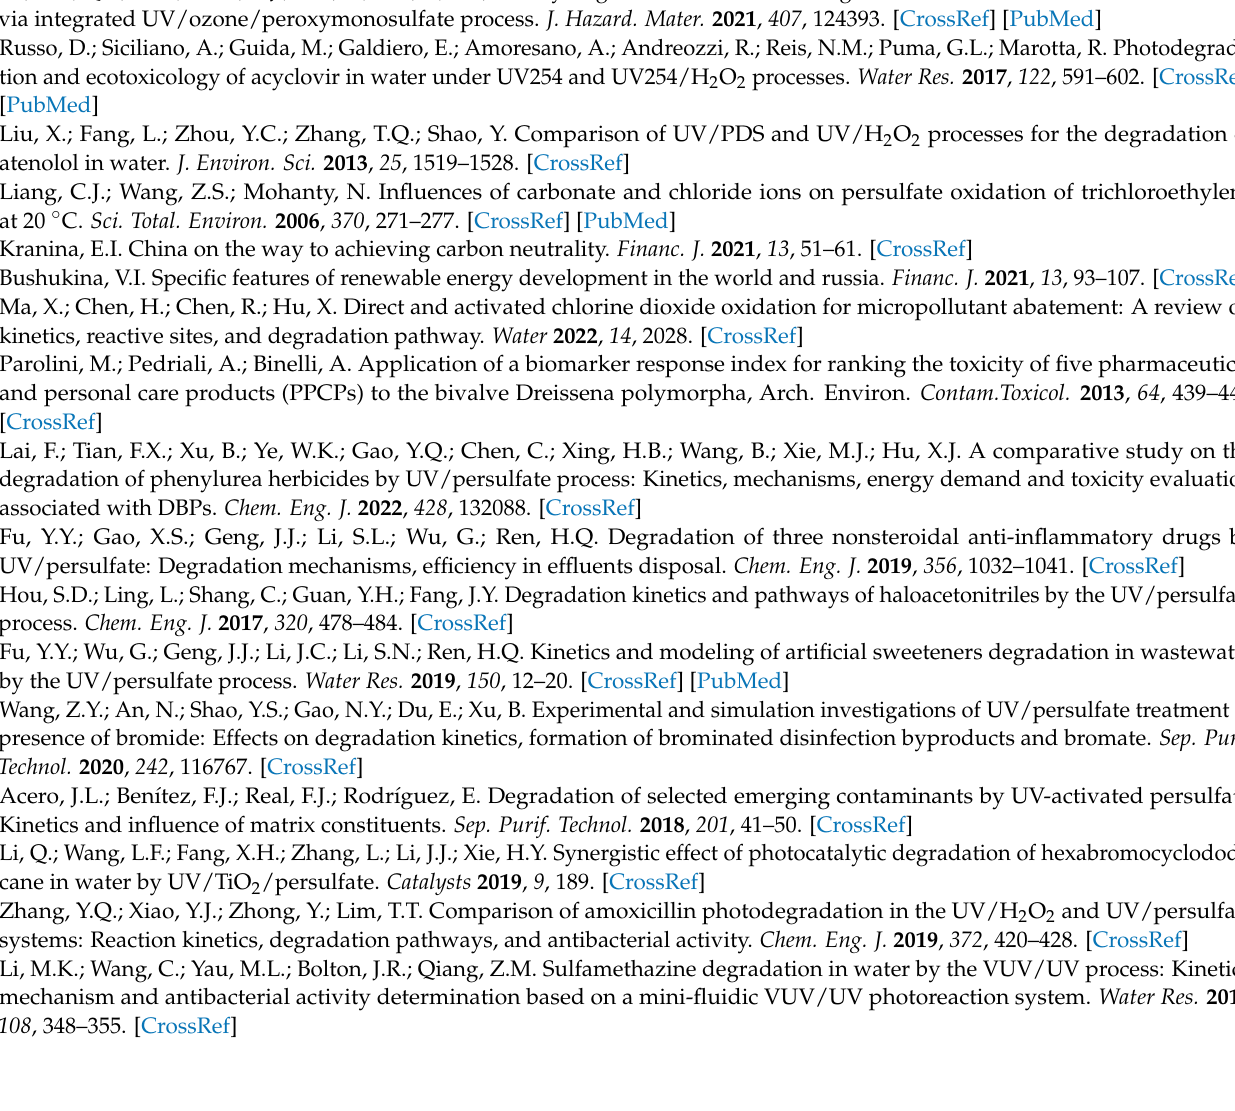
Figure S15: Structural formula of ACY(a) and ATL (b)